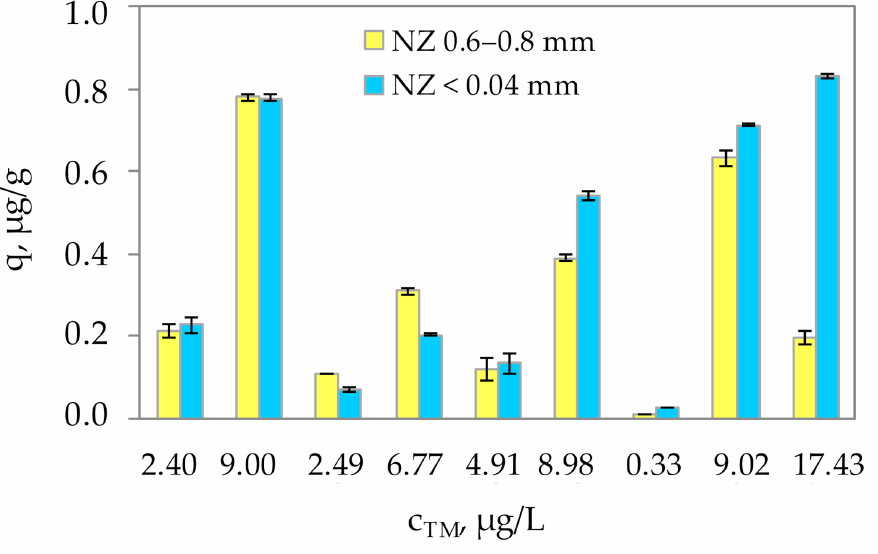
Figure 10. Mercury uptake (mean ± SD) onto natural zeolite of two particle sizes in dependence on the initial concentration of total mercury